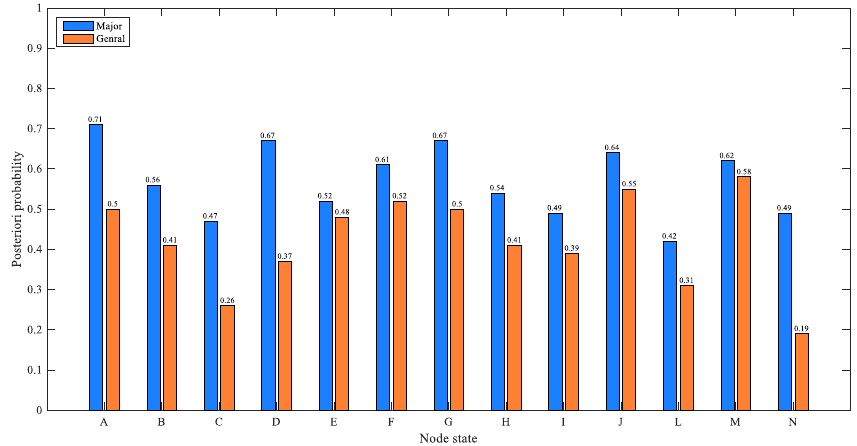
Figure 10. Estimated probabilities of the nodes under the most extreme situation of CPEAs.